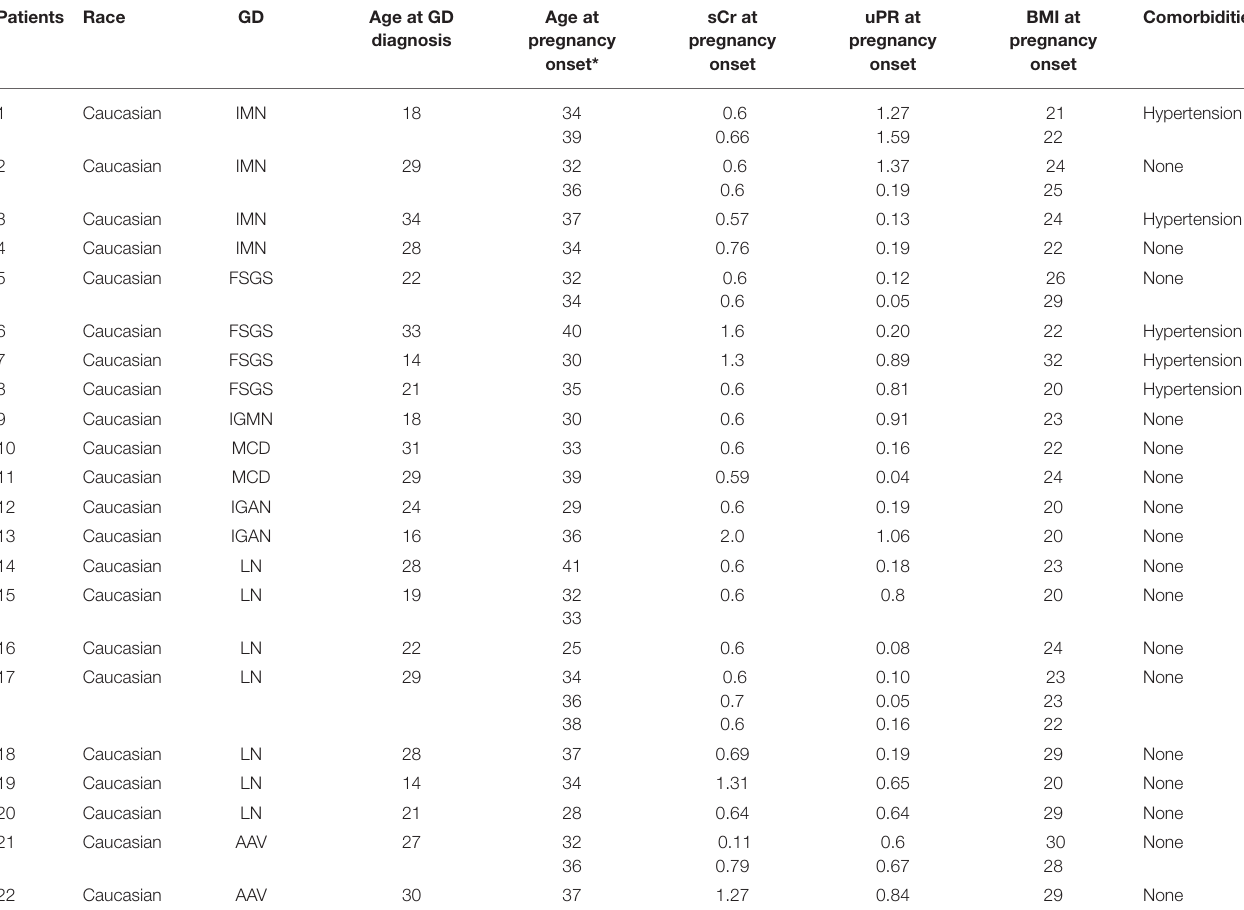
TABLE 1 | Demographic and baseline characteristics.